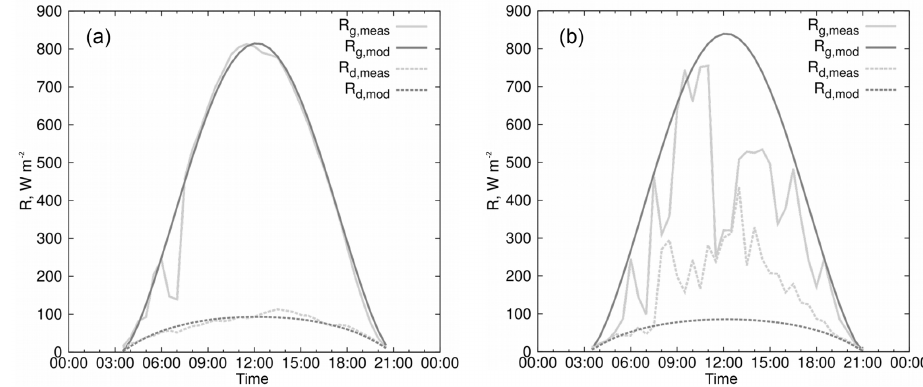
Figure 2. Modelled vs. measured irradiance for SMEAR Estonia: measured global radiation, R g , meas ; modelled global radiation, R g , mod ; measured diffuse radiation, R d , meas ; and modelled diffuse radiation, R d , mod . (a) 1 June 2016 – clear day; (b) 6 June 2016 – cloudy day. Timescale corresponds to local winter time (UTC + 2).